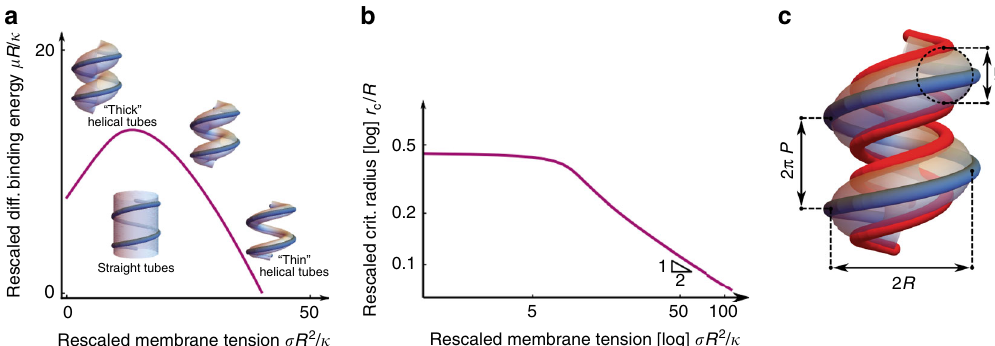
Fig. 4 Mathematical modeling of helical tubes ’ mechanical equilibrium. a Phase diagram showing the energetically favored shape between straight and helical tubes, as a function of the rescaled energy gain μ R/ κ associated with helical tubes with rescaled membrane tension σ R 2 / κ . The solid purple line is the phase boundary. b Rescaled critical radius r c /R of the tube at the transition from straight to helical as a function of the rescaled surface tension σ R 2 / κ . c Schematic of the more detailed fi lament elasticity model, which clusters together the fi laments bound in the equatorial (blue) and polar modes (red). Source data are provided as a Source Data fi